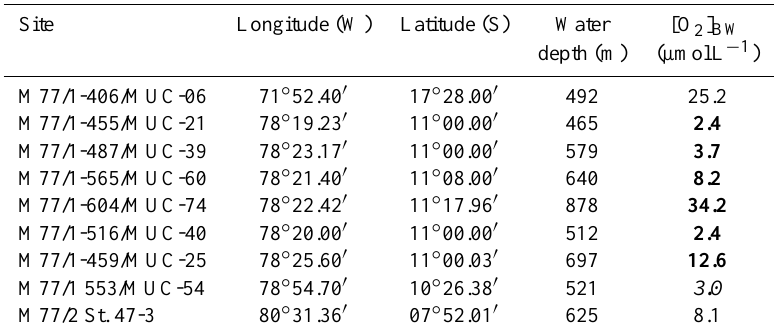
Table 1. Sampling sites. [O 2 ] BW in bold numbers are taken from Glock et al. (2011). [O 2 ] BW for station M77/1-406/MUC-06 is taken from the CTD profile from station M77/1-392/CTD-RO-4. [O 2 ] BW for station M77/2 St. 47-3 is taken from the CTD profile from station M77/2 St. 47-1 – CTD-19 (Krahmann, 2012). [O 2 ] BW in italic numbers indicates that this value was intrapolated from the closest CTD profiles available.